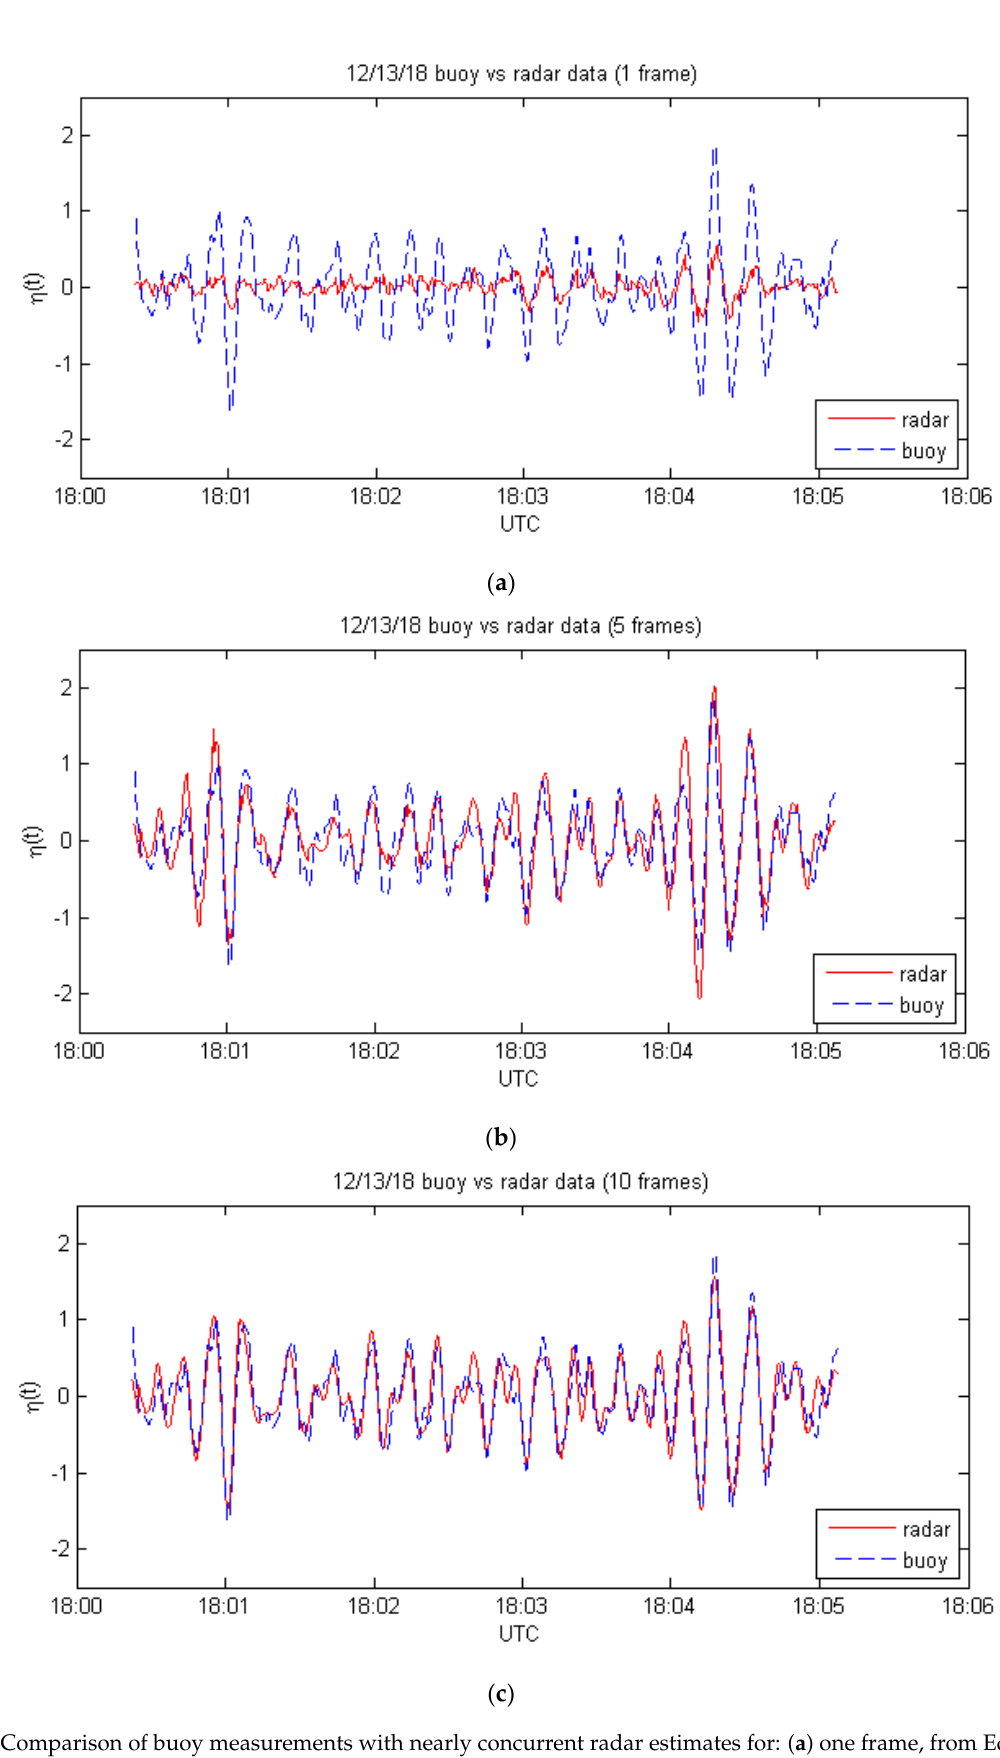
Figure 2. Comparison of buoy measurements with nearly concurrent radar estimates for: ( a ) one frame, from Equation (1); ( b ) 5 frames, from Equation (12); ( c ) 10 frames, from Equation (12).